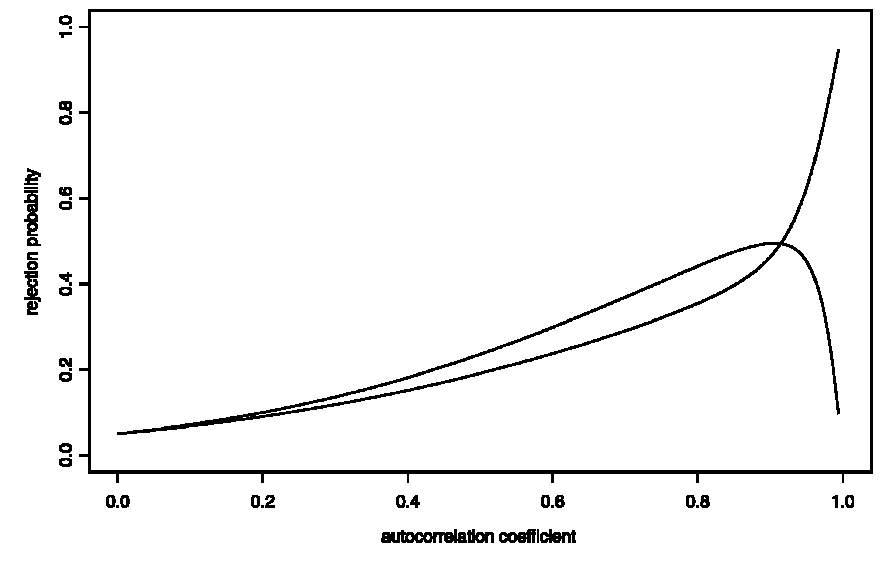
Figure 1 – Rejection probability of the